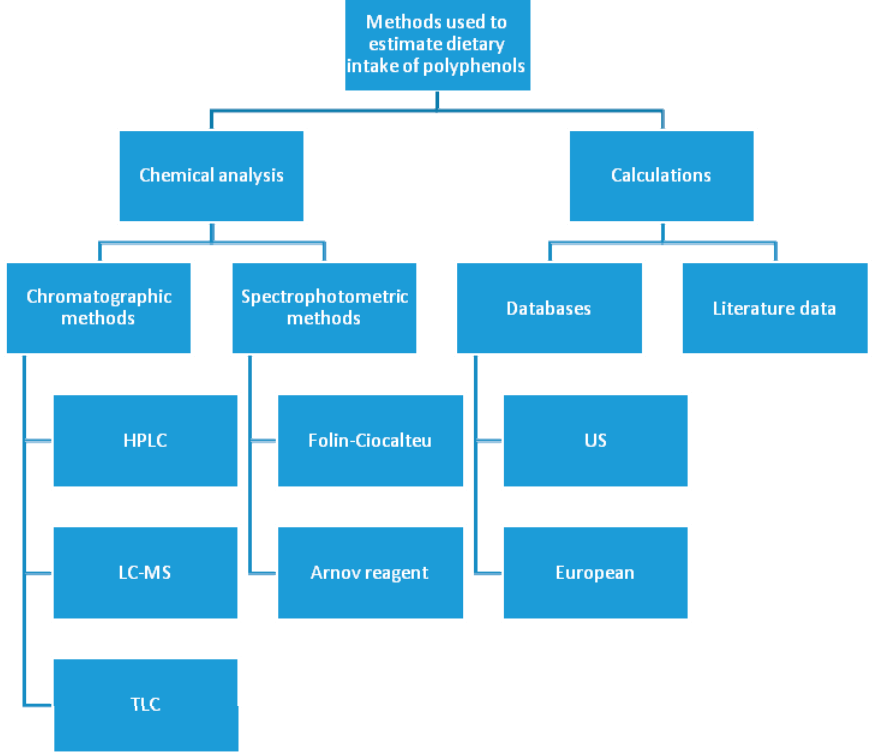
Figure 1. The most common methods used to estimate dietary intake of polyphenols.